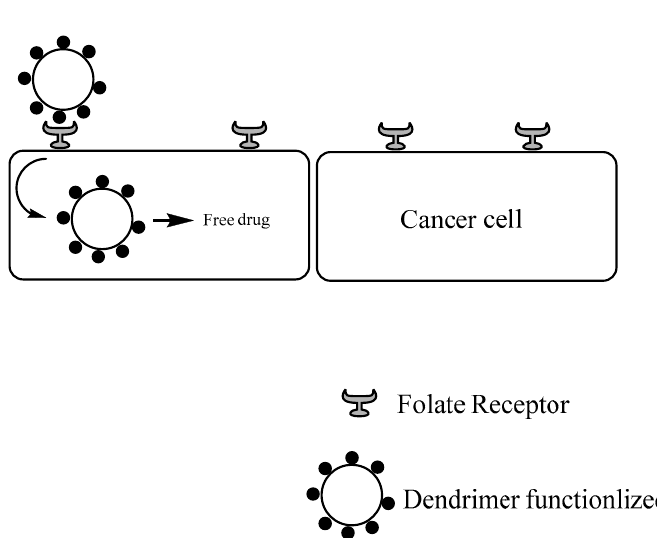
Figure 6. General targeting mechanism of FA-conjugated dendrimers.